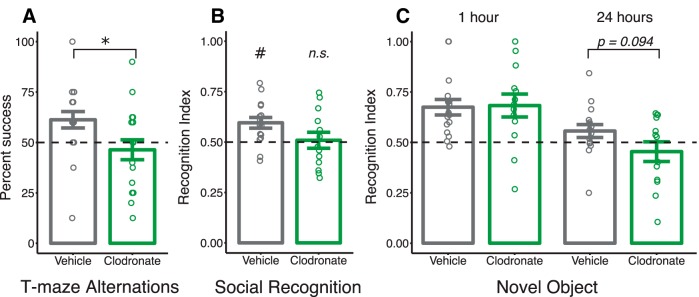
Postnatal microglia depletion induces selective memory impairment in juvenile rats. a, Percentage successful spontaneous alternations in a T-maze from PN25 to PN29. b, Social recognition index calculated on PN30 after a 30-min retention interval. c, Novel object recognition index calculated after a 1-h (PN26) and 24-h (PN27) retention interval. Bars indicate group means ± SEM for VEH-treated (black) and LC-treated (green) rats of both sexes. Open circles represent data from individual rats. Horizontal dashed line indicates score equal to chance (a–c). *p < 0.05. #p < 0.01 compared with chance. n = 18–20 (a) and 13–16 (b, c) per treatment.